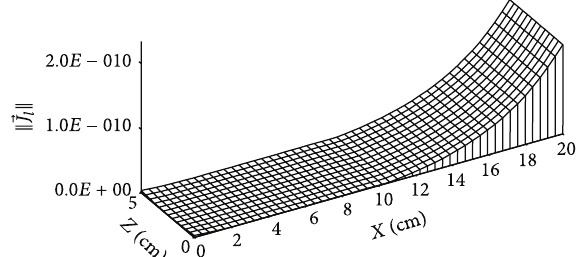
Figure 10: Distribution of liquid mass flow (in kg/m 2 ⋅ s) for 𝑡 = 4 days.